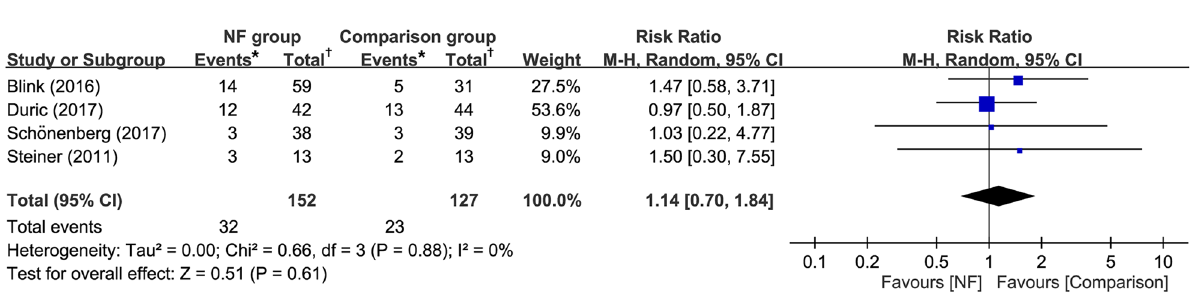
Figure 6. Forest plot for comparing symptoms of attention-deficit hyperactivity disorder between EEG-NF and comparison groups during 6–12 months follow-up. CI, confidence interval; IV, inverse variance; Std, standardized.